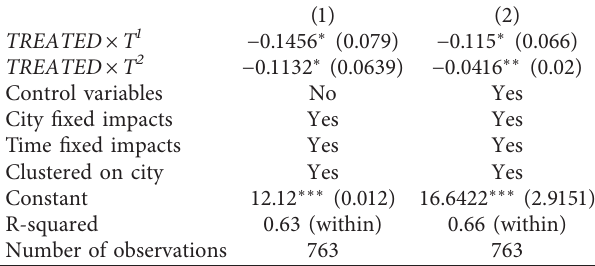
Table 6: Dynamic effect of hailing services on the use of private cars urban